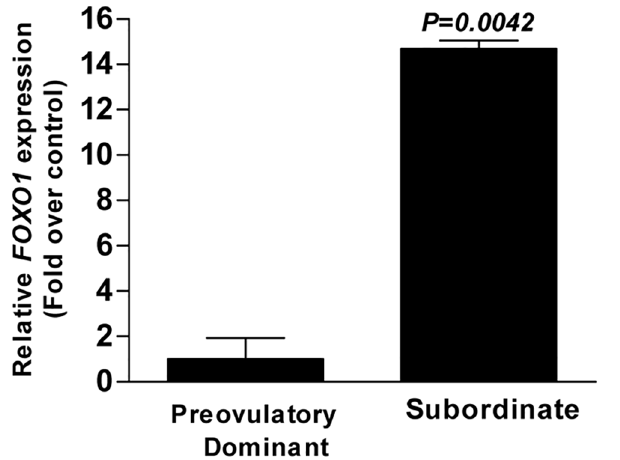
Fig 9. FOXO1 is enriched in granulosa cells of subordinate follicles. The relative expression of FOXO1 ; a validated target of miR-183 cluster was quantified in granulosa cells of preovulatory dominant and subordinate follicles using qPCR. The relative expression of target transcript was normalized to the GAPDH . Statistical significance between groups was analyzed by two-tailed student t-test. Expression data is presented as mean ± SD of normalized Ct value of biological